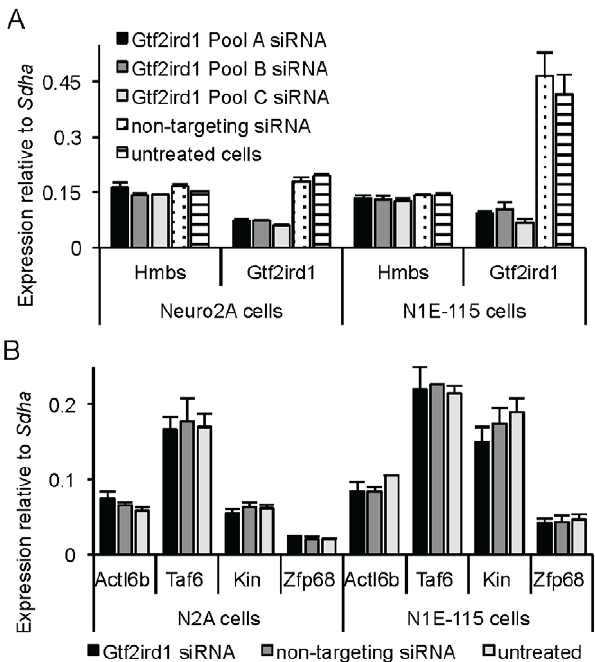
Figure 3. Knockdown of Gtf2ird1 in neuronal cell lines Neuro2A and N1E-115. Expression values are shown relative to the house- keeping gene Sdha . A. Three different pools of Gtf2ird1 -siRNAs were tested, each in two separate transfections. Expression of the housekeeping gene Hmbs was not affected by siRNA treatment. B. Expression of candidate genes in Gtf2ird1 -siRNA treated neuronal cell lines. Expression of genes transfected with each of the different Gtf2ird1 -siRNA pools were averaged together (n=6). No statistically significant changes in expression were detected between Gtf2ird1 - siRNA treated cells and non-targeting siRNA treated or untreated cells using Student’s t-test.